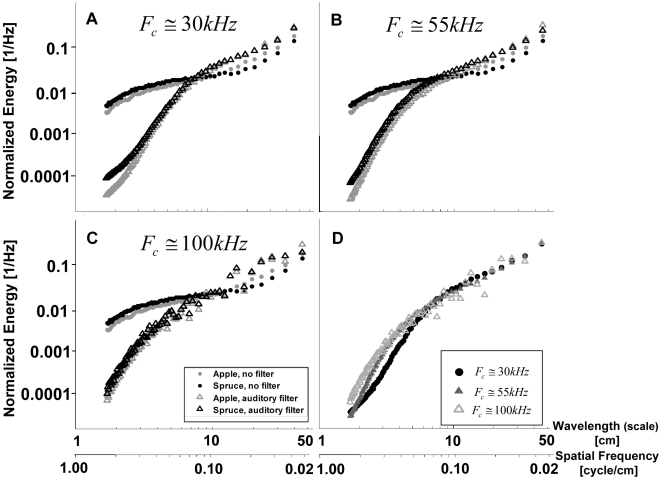
The effect of the auditory system.A–C) Normalized echo spectra of two species (apple and spruce) after auditory system filtering compared to the spectra of the same species with no filtering. The system response is represented by the output of three channels with different center frequencies (Fc) representing the entire frequency range. (A) , (B) , (C) . The energy was normalized to a sum of one. D) The output of the three channels of apple (appearing in A–C) are overlaid to emphasize the differences between them.